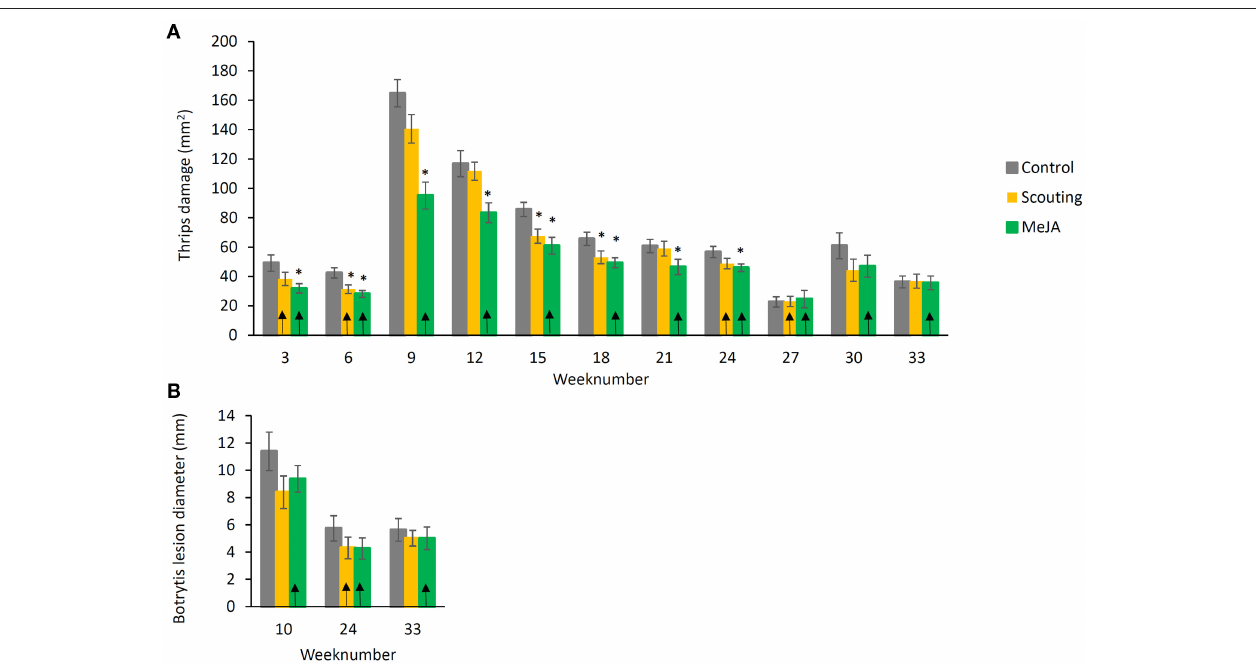
FIGURE 4 | Plant resilience during the strawberry cropping cycle. (A) Thrips damage and (B) Botrytis lesions in detached leaf bioassays. Plant resilience against thrips was evaluated every 3 weeks. Plant resilience against Botrytis was evaluated in weeks 10, 24, and 33. Control: leaves from mock-treated plants, Scouting: leaves from plants treated with 1mM MeJA when this was deemed necessary based on scouting, occurring in weeks 2, 5, 23, and 26. MeJA: leaves from plants that were treated with MeJA every 3 weeks. Upward arrows ( ↑ ) indicate that plants received MeJA treatment in the previous week. Data present mean ± SEM ( n = 10). Significant differences are indicated as p ≤ 0.05 * based on a Kruskal–Wallis